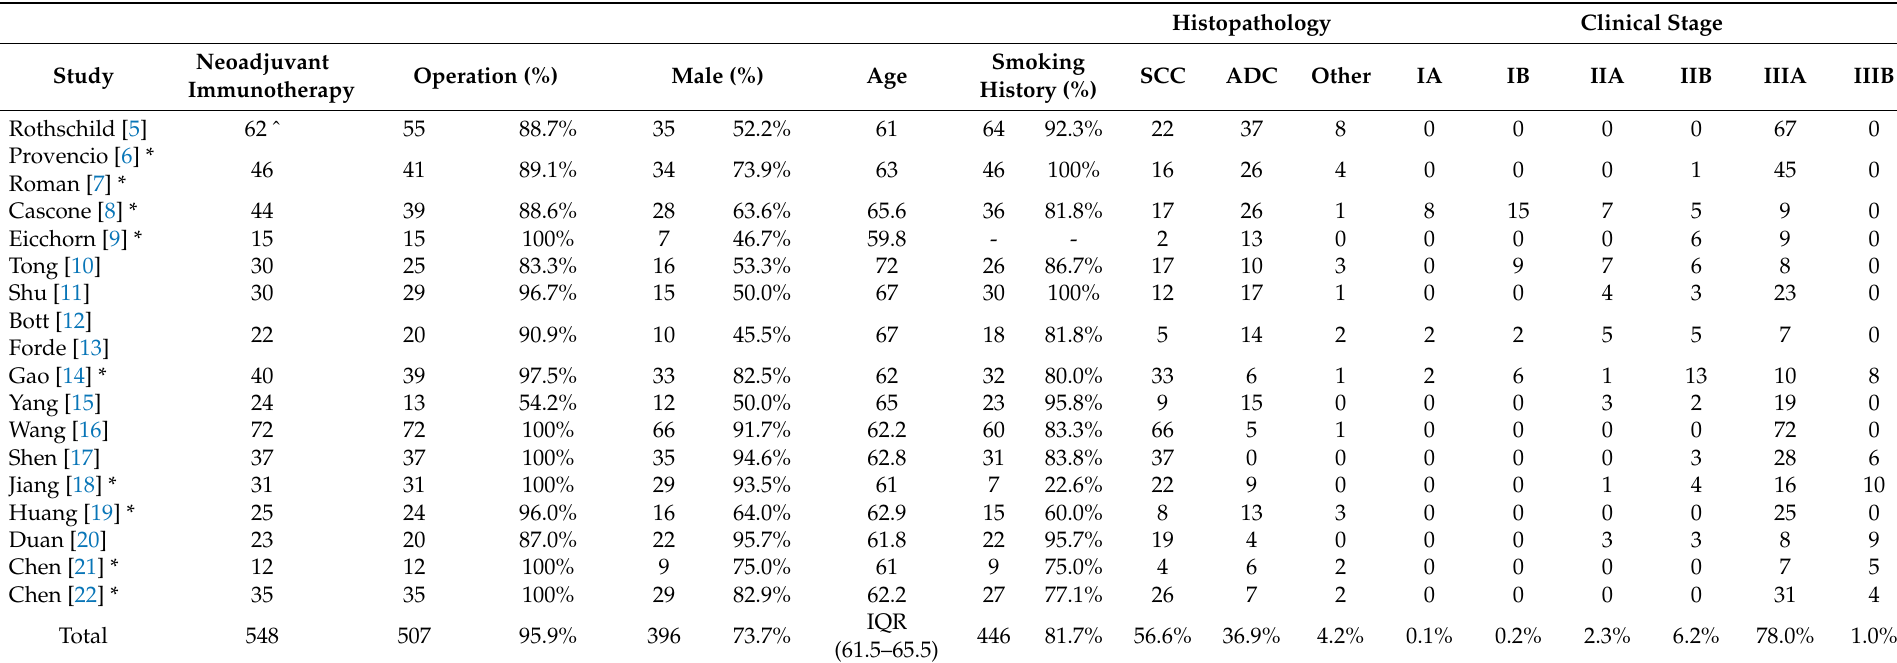
Table 2. A summary of baseline patient characteristics in selected studies on neoadjuvant immunotherapy for resectable non-small cell lung